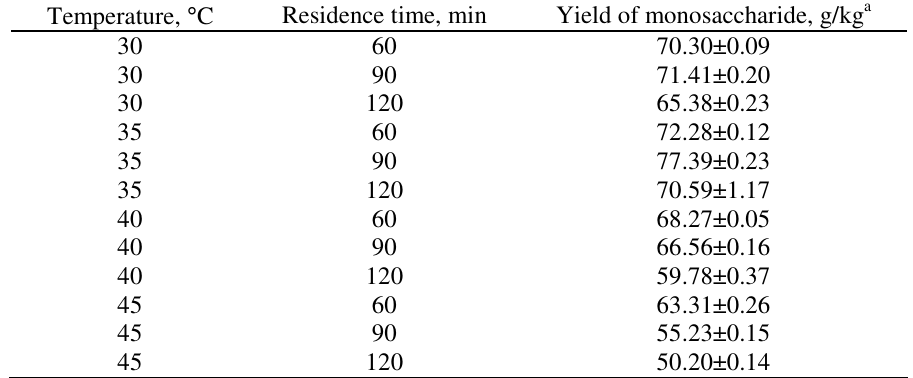
Table 2. Monosaccharide yield obtained from diluted alkali hydrolysis of paper fibre residue (PFR) Temperature, ° C Residence time, min Yield of monosaccharide, g/kg a